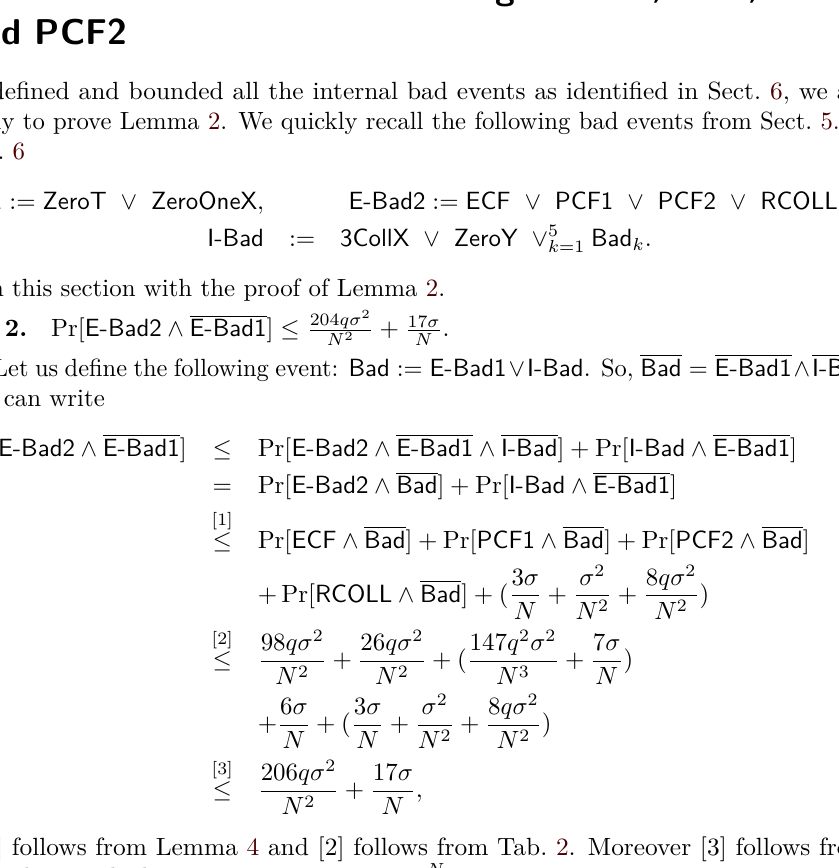
Table 2: List of the events to be bounded with their corresponding bound. Event to be Bounded Bounds of the Event Reference in the Paper RCOLL ∧ Bad 6 σ Section 7.1 N ECF ∧ Bad Section 7.2 Section 7.3 Section